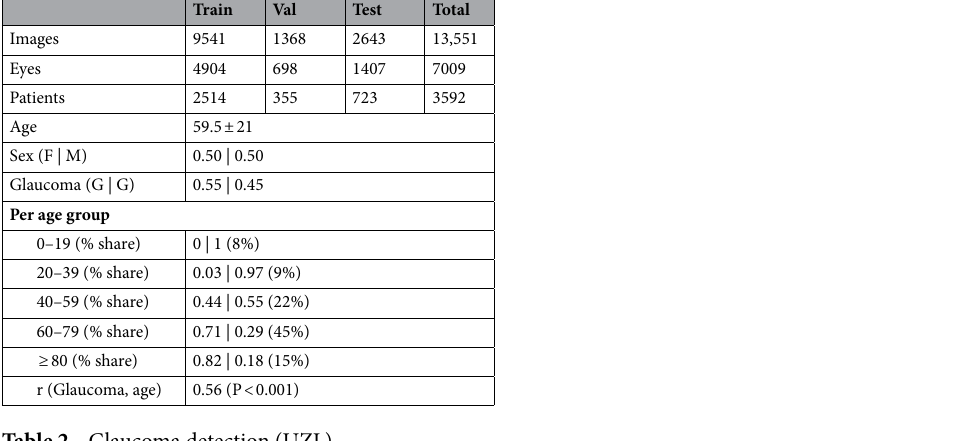
Table 2. Glaucoma detection